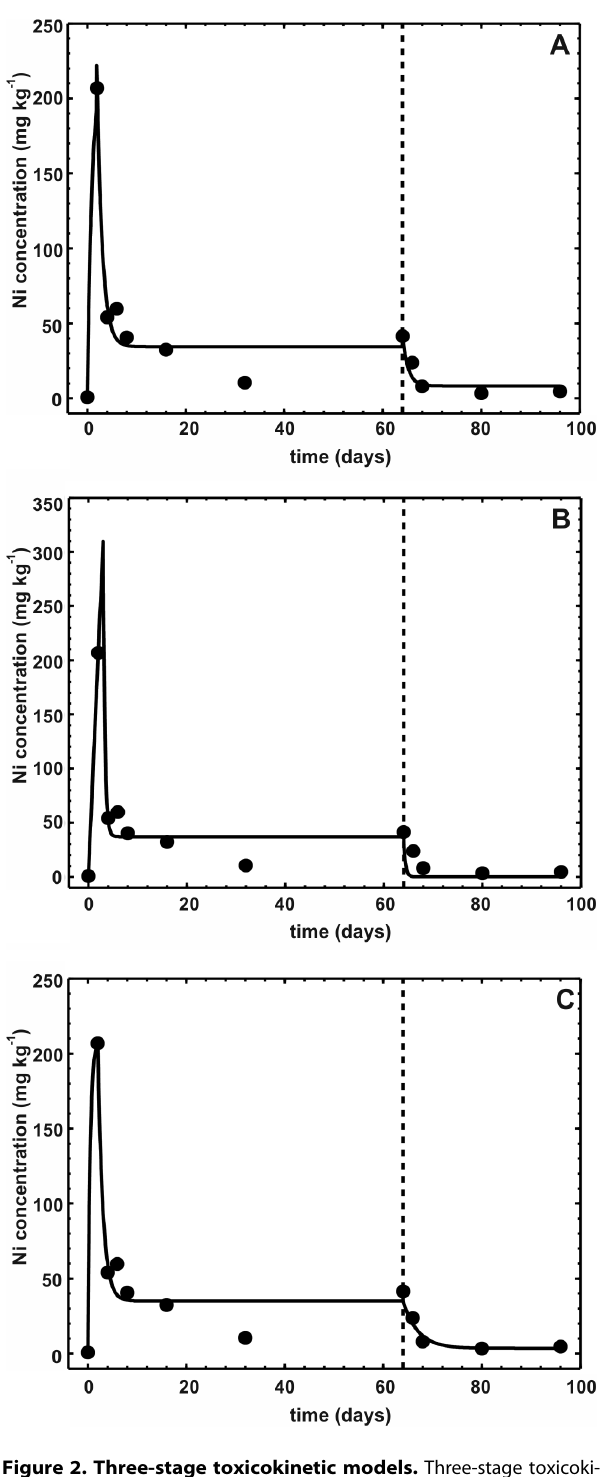
Figure 2. Three-stage toxicokinetic models. Three-stage toxicoki- netic models fitted to geomean Ni concentrations in the ground beetle Pterostichus oblongopunctatus : a) model by Laskowski et al. [17]; b) exact-solution model, case scenario with one uptake rate and two different elimination rates; c) exact-solution model with all assimilation and elimination rates stage-specific (Eqs. 15–19). Vertical broken line indicates the day of changing to uncontaminated food ( t c ).